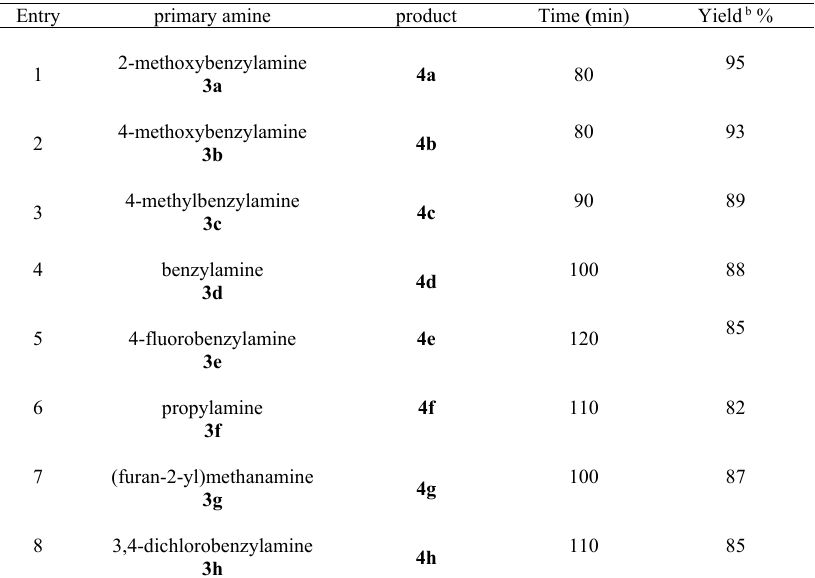
Entry primary amine product Time ( min) Yield b %